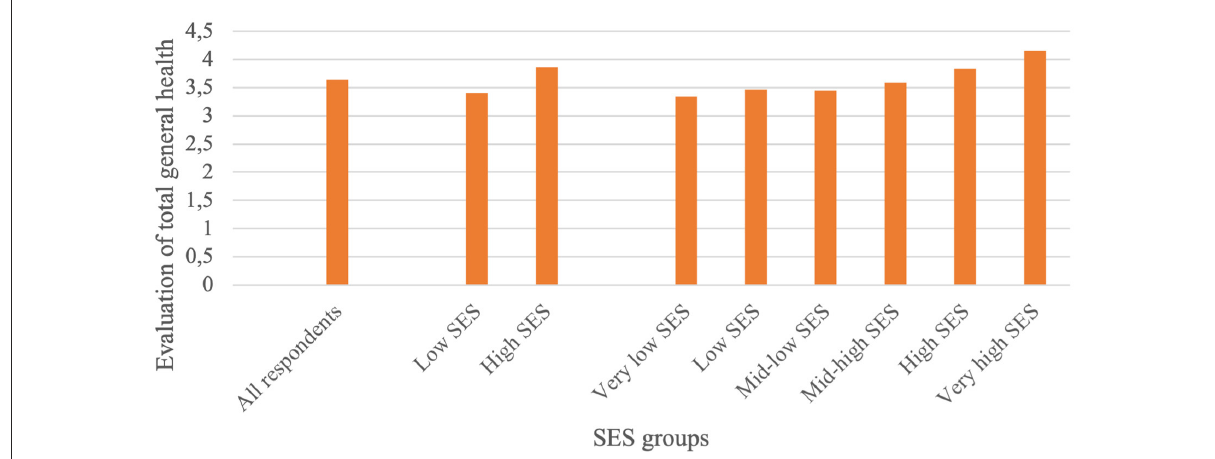
FIGURE4 Mean scores of the evaluation of TGH.